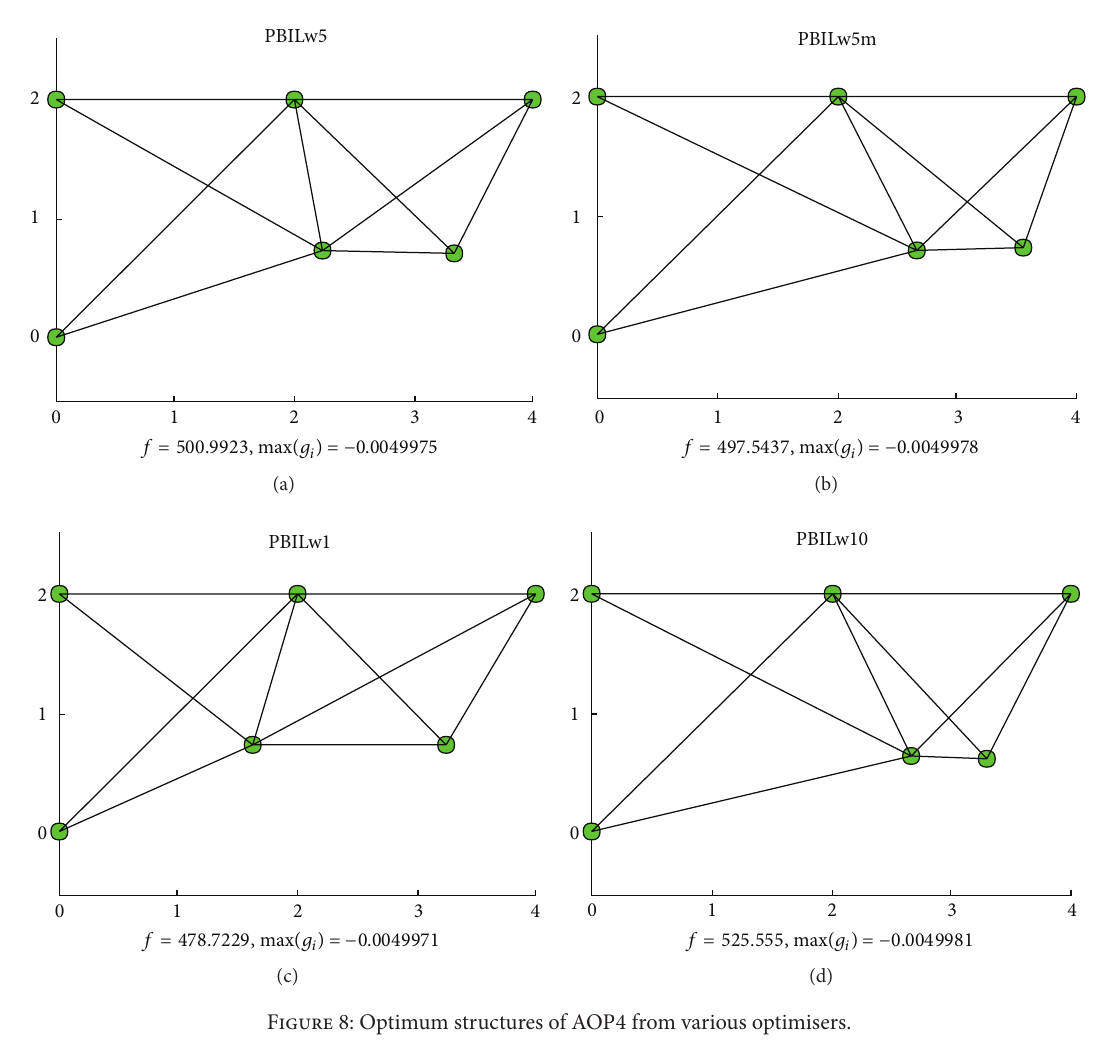
Figure 8: Optimum structures of AOP4 from various optimisers.